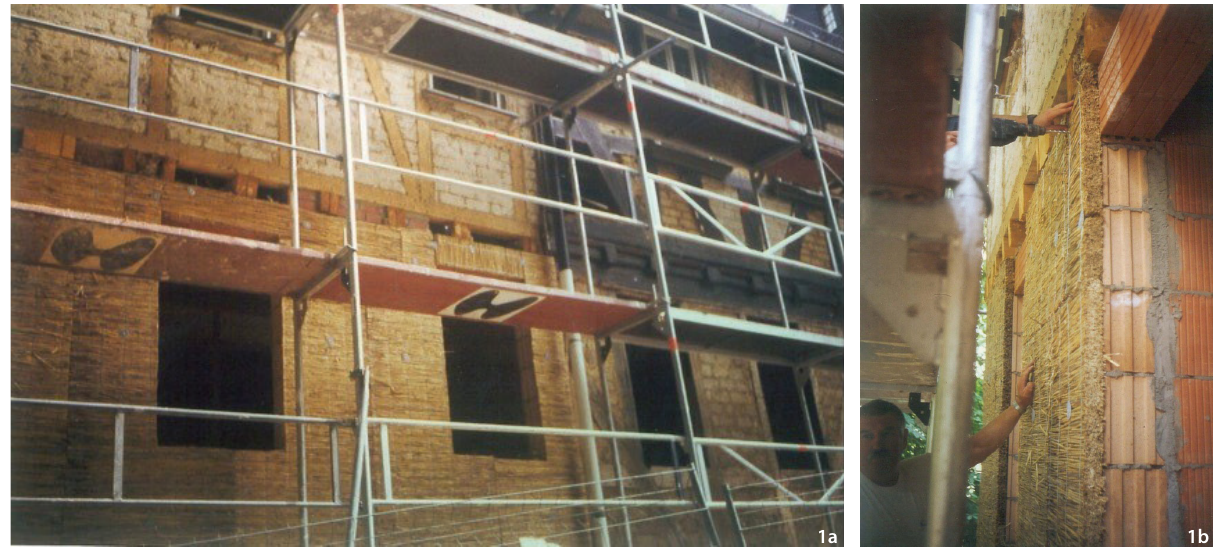
Figure 1 Reed insulation was installed during the restoration of the ‘Lottehaus’ in Wetzlar, Germany (Source: the